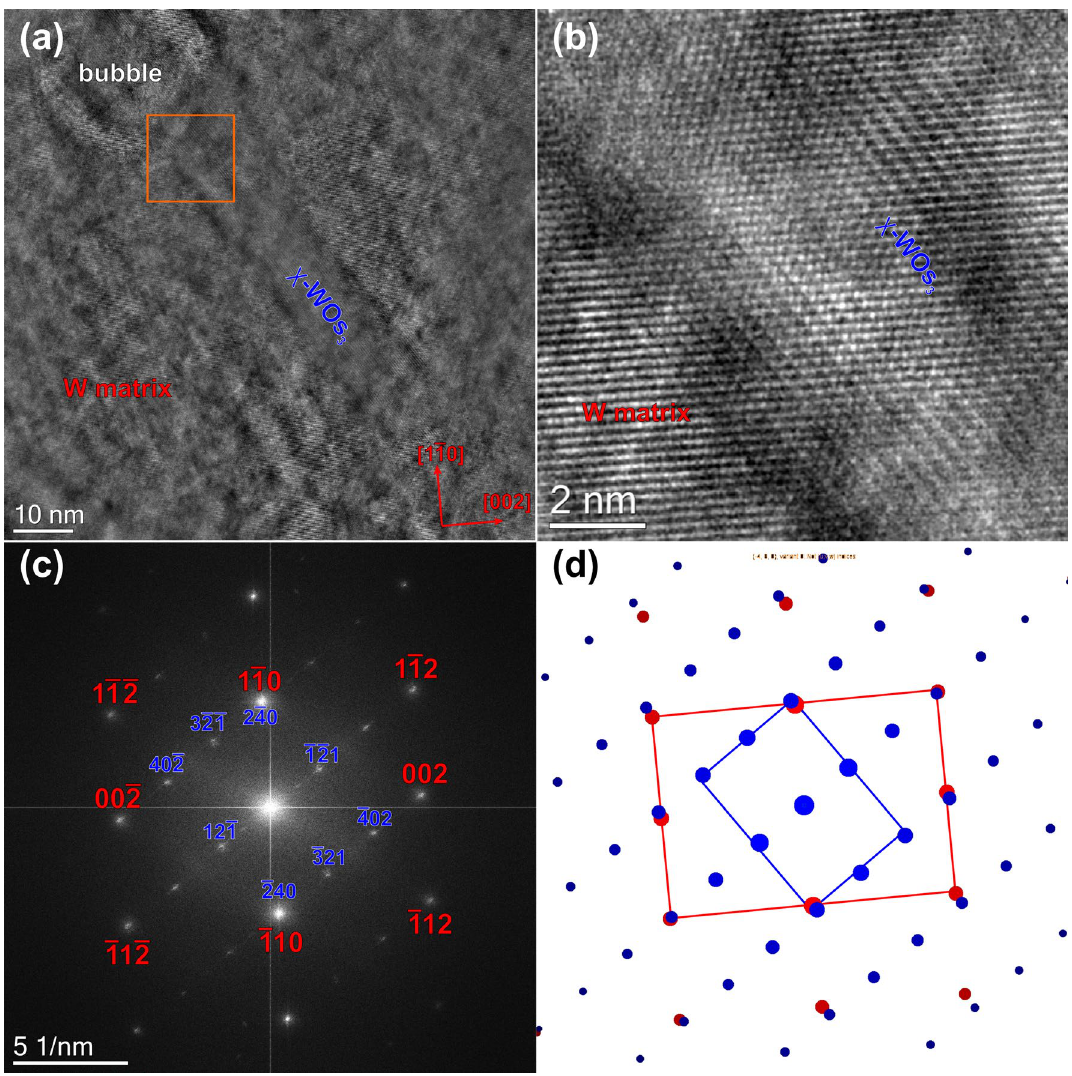
Figure 8. ( a ) High-resolution phase contrast image of a rod-shaped Os-rich precipitate, which is identified as the WOs 3 χ -Phase. Magnified view ( b ) and diffractogram (FFT) ( c ) of the region delimited by the orange square in ( a ). Simulated model of the diffractogram ( d